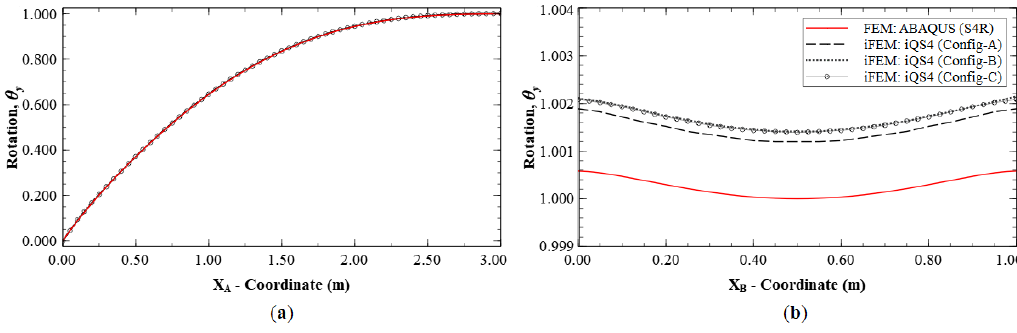
Figure 7. Line plots of rotation ( 𝜃 𝑦 ) for Mode 1 along: ( a ) section A-A’; and ( b ) section B-B’.